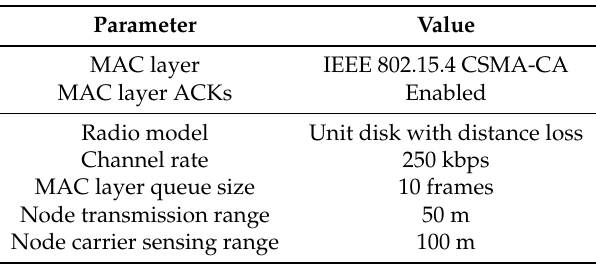
Table 1. Cooja Simulation Parameters.